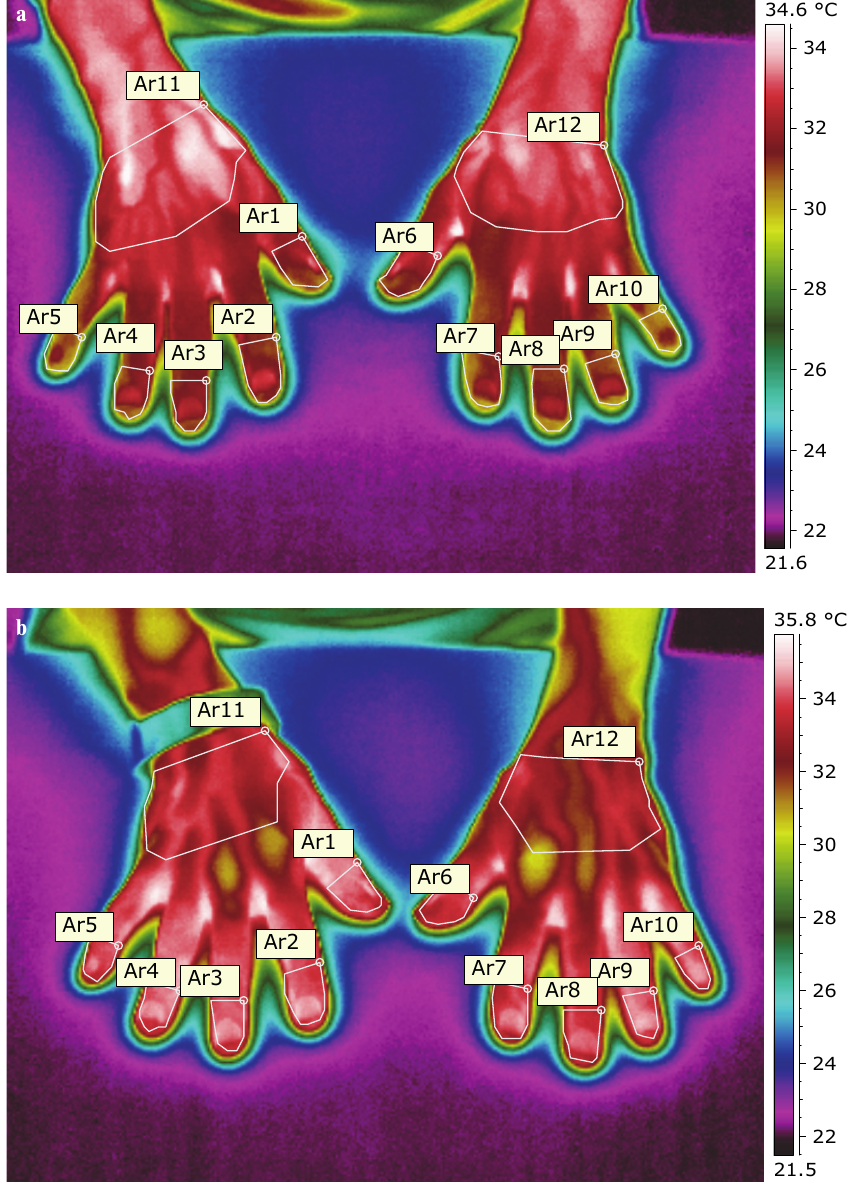
Fig. 1. Physiological finding during the IRT